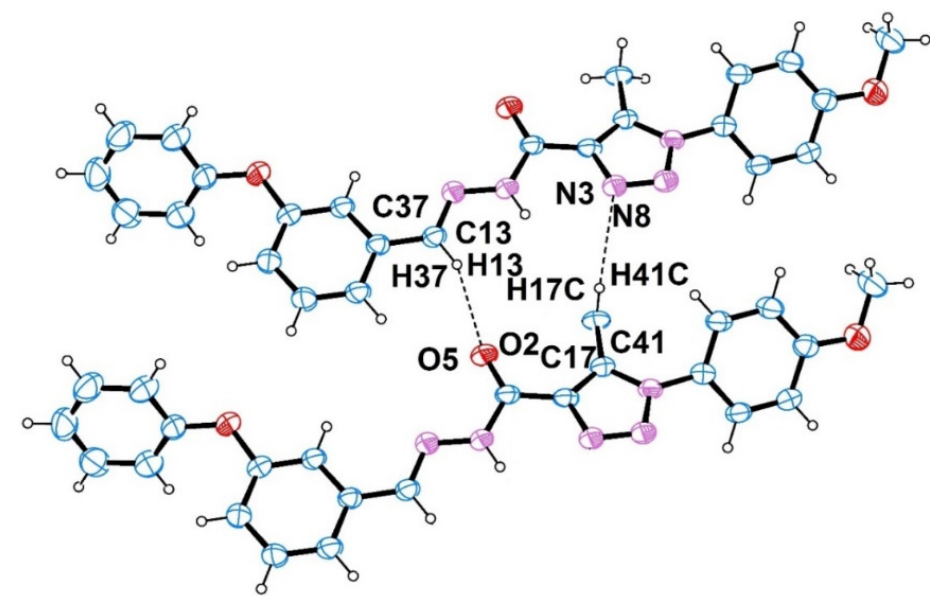
( 13 ) ) in the crystal 2